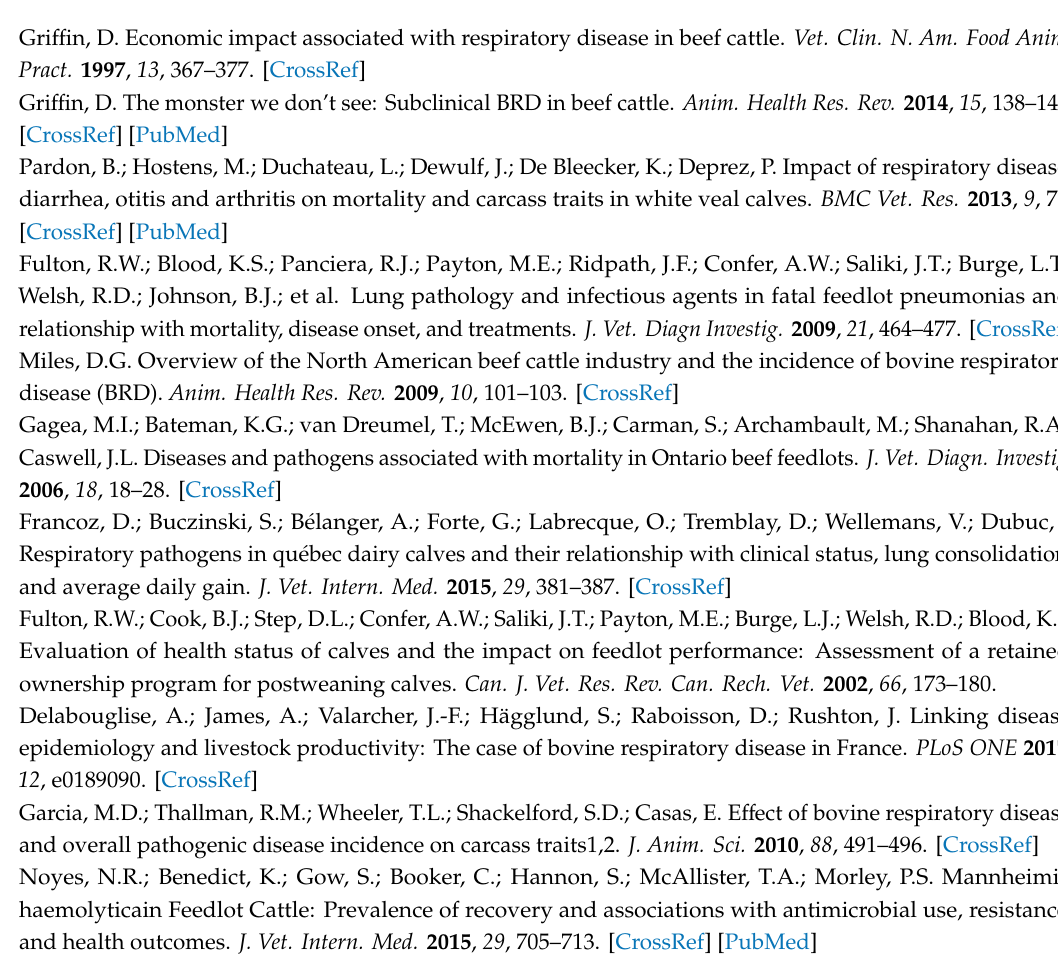
Table S1: Commercial kits employed to perform RT-PCR analysis, Table S2. Prevalence of pneumonia in relation with age and management system, Table S3. Parameter estimates of the model predicting log odds of severity of lesions (log-probability of be grade II (severe) / probability of be grade I (mild)) and crude and estimated occurrence of severe lesion, Table S4: Etiological agents identified by PCR in each type of pneumonia. Author Contributions: Design and writing the paper, M.F.; design and supervision, V.P.; sample collection and histopathological analysis, M.F. and M.d.C.F.; draft preparation, J.B.; statistical design and analysis, F.J.G. All authors have read and agreed to the published version of the manuscript. Funding: This work was supported by the research funds of the Ruminant Health and Pathology research group of the University of Le ó